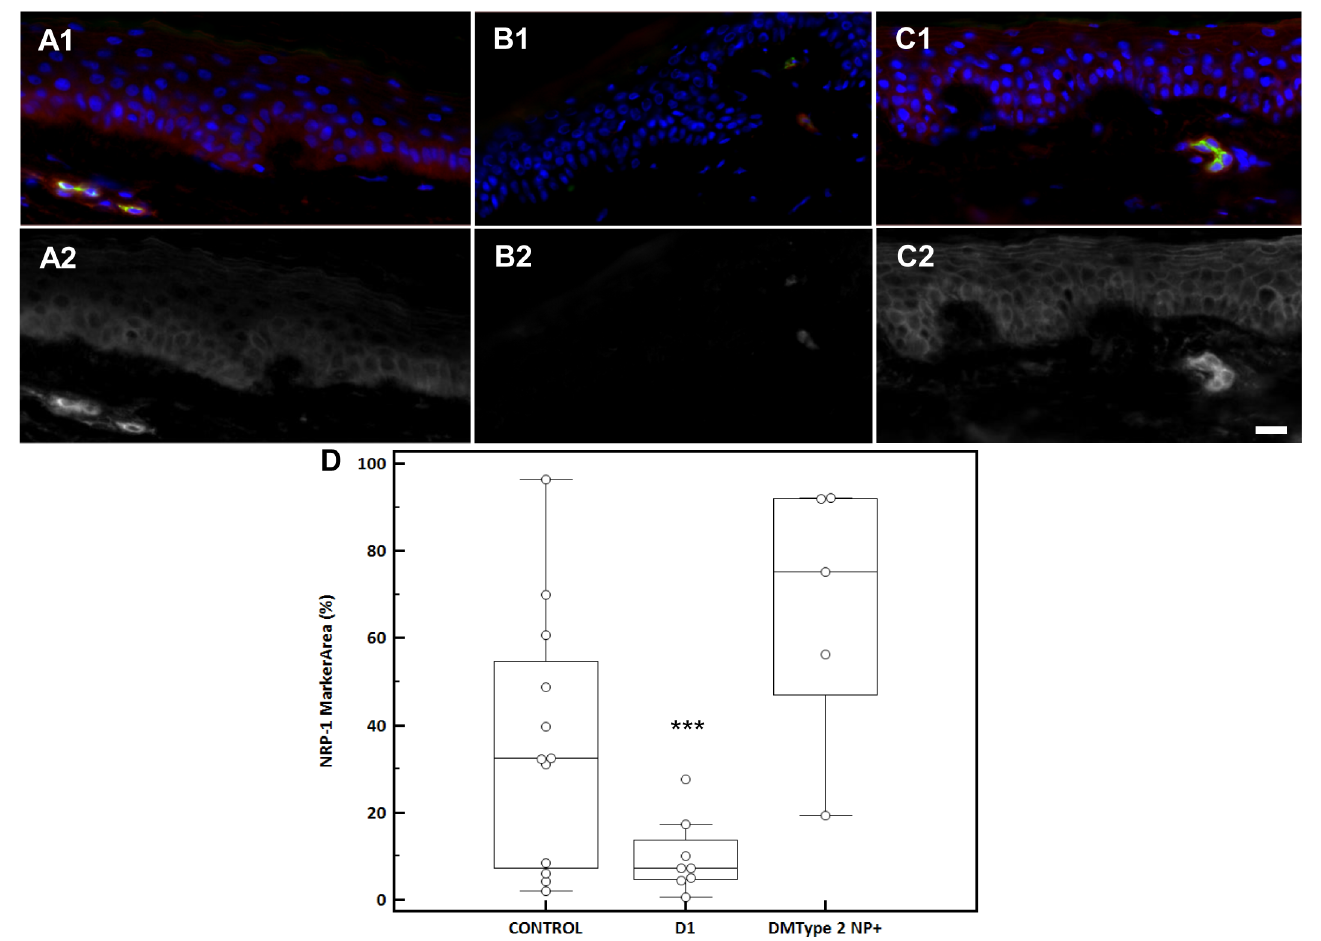
Fig 5. NRP-1 Receptor expression in the epidermis of control, D1 capsaicin treated and DM Type 2 NP+ subjects. NRP-1 receptor (red) and CD31 (green) expression pattern in epidermis as obtained by NRP-1/CD31 immunofluorescence in human skin biopsy of (A) healthy subject,(B) capsaicin treated healthy subject on day 1 (D1), (C) DM Type 2 NP+ diabetic subject. The lower panel (A2, B2, and C2) shows a grey scale image of NRP-1. Hoechst nuclear counterstain (blue). Scalebar: 20 μ m. (D) Multiple comparison graph of NRP-1 Marker area (%) in epidermis of control, D1 and DM Type 2 NP+ subjects. * p <